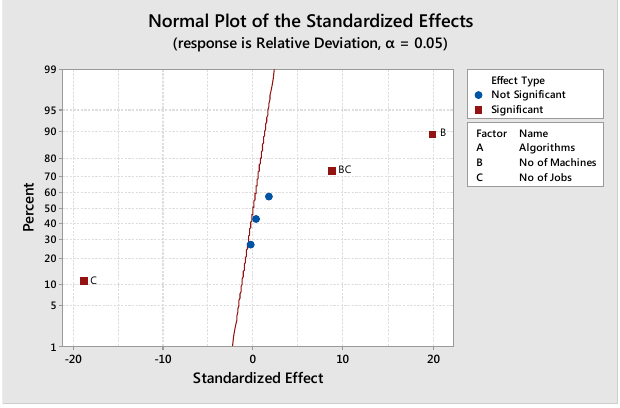
Normal Plot of the Standardized Effects (response is Relative Deviation, α =